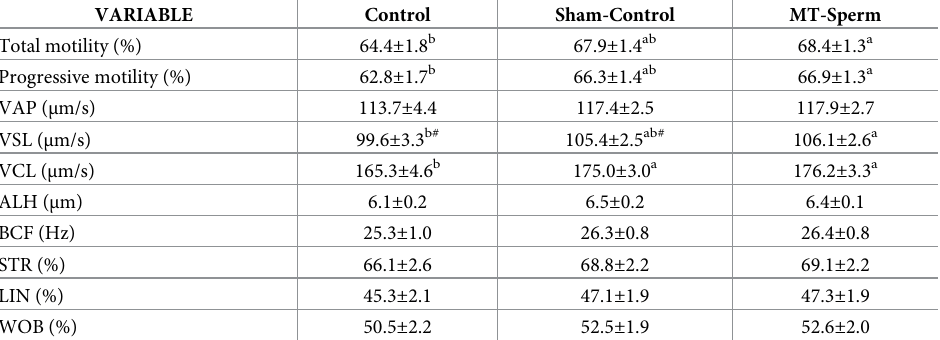
Table 2. Effects of melatonin addition (all time points combined: 30 min, 120 min, and 180 min) to the IVF proto- col on sperm motion parameters assessed via CASA (LS mean ± SEM).